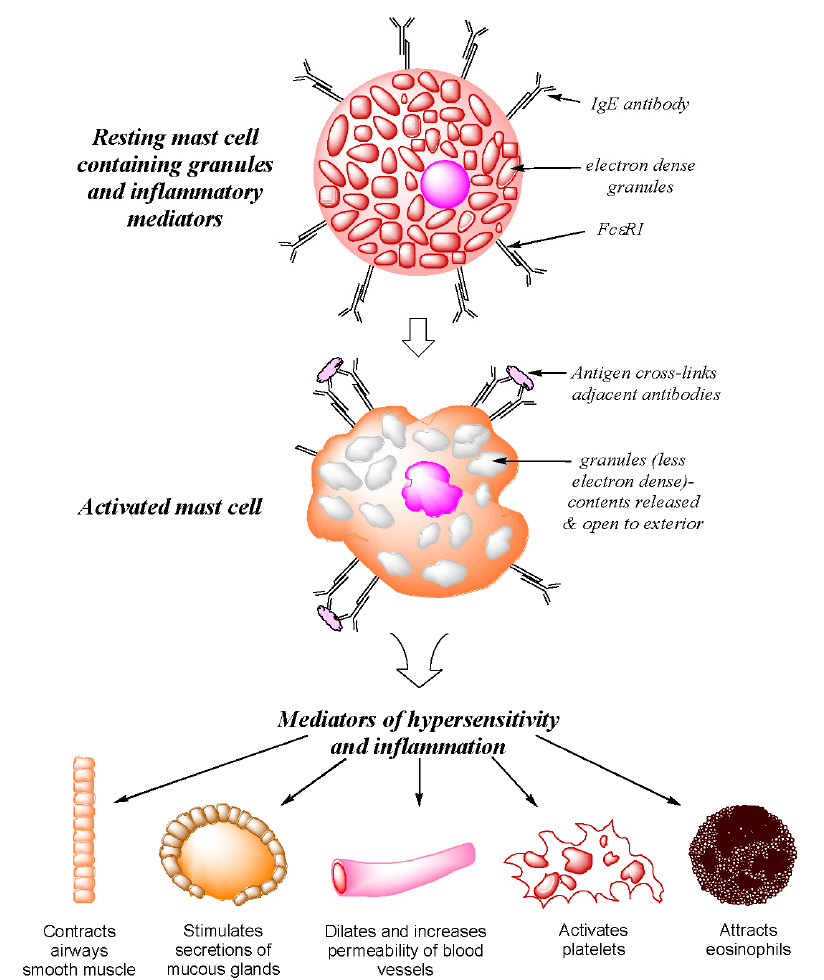
Figure 1. Diagrammatic representation of allergen-induced mediator release from sensitized mast cells and their main physiological and pharmacological effects on body